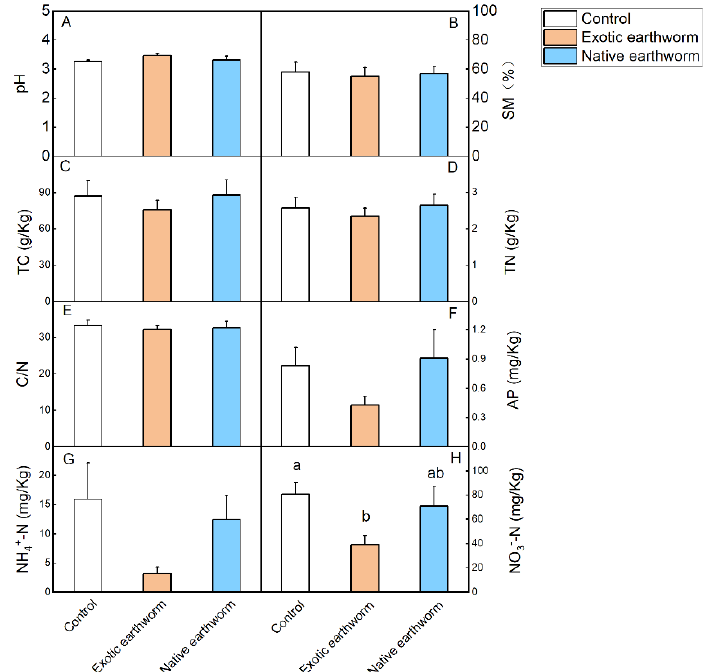
Figure 1. Soil chemical properties as affected by the presence of exotic and native earthworms. Soil pH ( A ); SM: soil moisture ( B ); TC: soil total carbon (g kg − 1 dry soil) ( C ); TN: soil total nitrogen (g kg − 1 dry soil) ( D ); C/N ratio ( E ); AP: available phosphorus (mg kg − 1 dry soil) ( F ); NH 4+ -N: nitrogen from ammonium (mg kg − 1 dry soil) ( G ); NO 3 − -N: nitrogen from nitrate (mg kg − 1 dry soil) ( H ). Data represent means + standard error (n = 5). Significant ( p < 0.05) effects based on one-way ANOVA (Table S2) are presented by different lowercase letters above each column. No letters means there was no significant